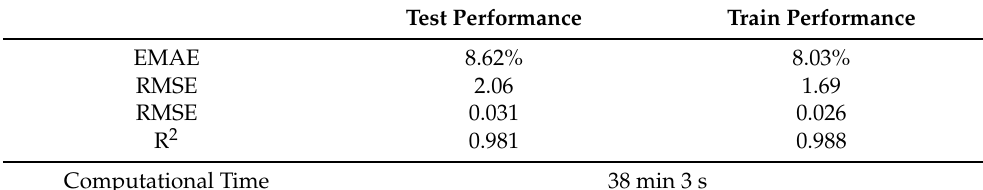
Table 6. Model performance for prediction of the SO 2 emissions: values of the errors evaluated on the training and testing data and related computational time